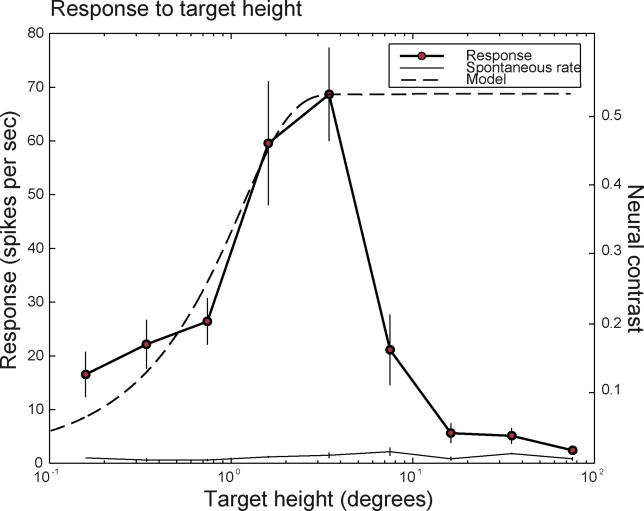
Length Tuning of STMD 1 Neurons Sharply Tuned to Small FeaturesThe strongest spiking response is seen to small bars (0.8° × 3° of the visual field). Larger bars moving through the receptive field elicit no response. Error bars show standard error of the mean of experiments in different neurons of the same STMD class (n = 9). The dashed line shows the output of a model for apparent contrast of targets of different size, as viewed by a single photoreceptor centered on the target (seeMaterials and Methods). Close fit between the model output and the lower part of the neuron response tuning suggests that attenuation of responses to targets below the optimum is due to reduction in their apparent contrast, not the smaller size per se.